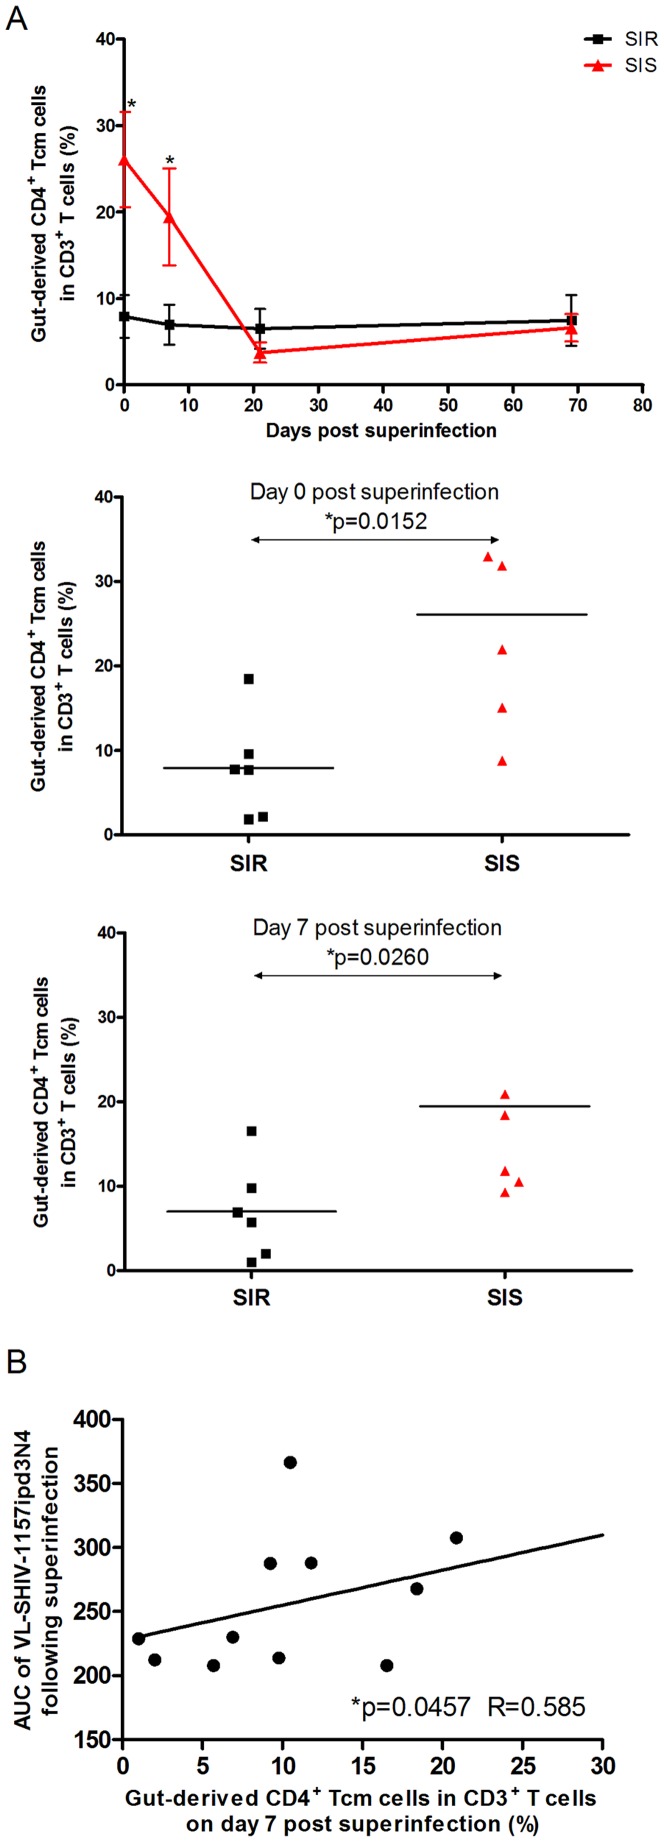
Correlation of superinfection with the percentage of CD4+ Tcm cells in CD3+ T cells from GUT after SHIV-1157ipd3N4 inoculation.(A) Percentage of gut-derived CD4+ Tcm cells in CD3+ T cells in SIS (red line) and SIR monkeys (black line) at each time point after superinfection, particularly on days 0 (*P = 0.0152) and 7 (*P = 0.0260) after SHIV-1157ipd3N4 inoculation (Mann-Whitney U test, *P<0.05). (B) Correlation between the AUC of SHIV-1157ipd3N4 viremia following superinfection and the percentage of gut-derived CD4+ Tcm cells in CD3+ T cells on day 7 after SHIV-1157ipd3N4 inoculation (Pearson's correlation test, R = 0.585, *P = 0.0457).